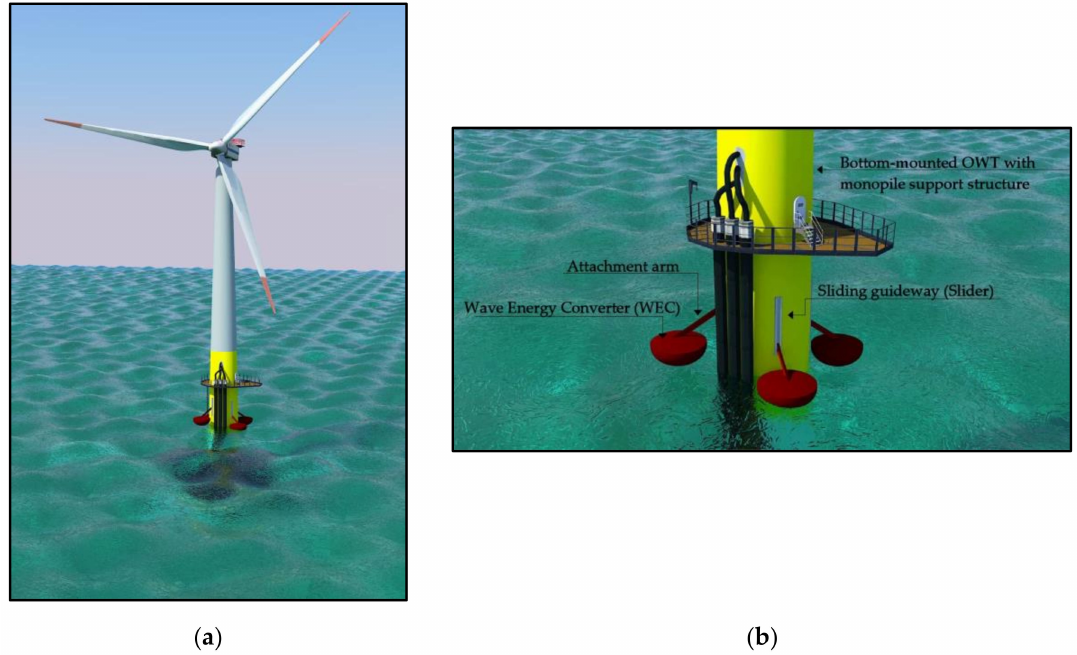
Figure 1. Proposed hybrid offshore wind and wave energy exploitation system: ( a ) conceptual representation; ( b ) view of the WECs’ attachment on the bottom-mounted